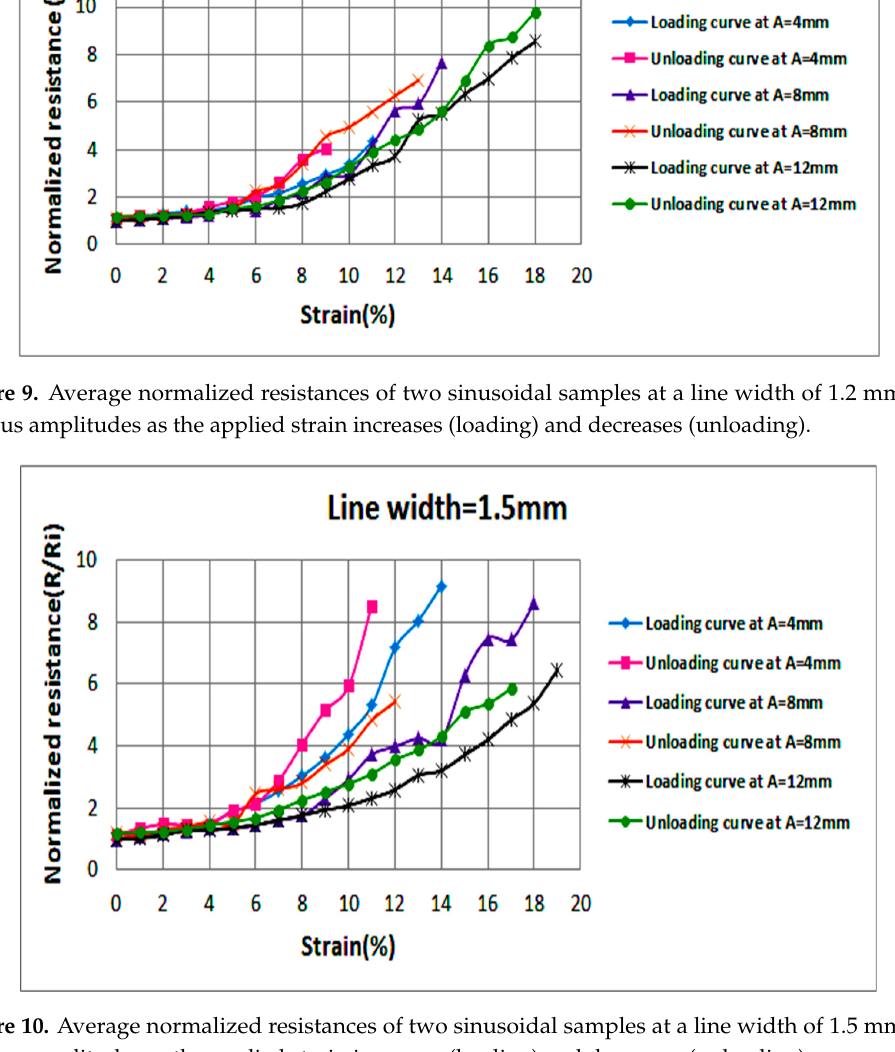
Figure 10. Average normalized resistances of two sinusoidal samples at a line width of 1.5 mm and various amplitudes as the applied strain increases (loading) and decreases (unloading).